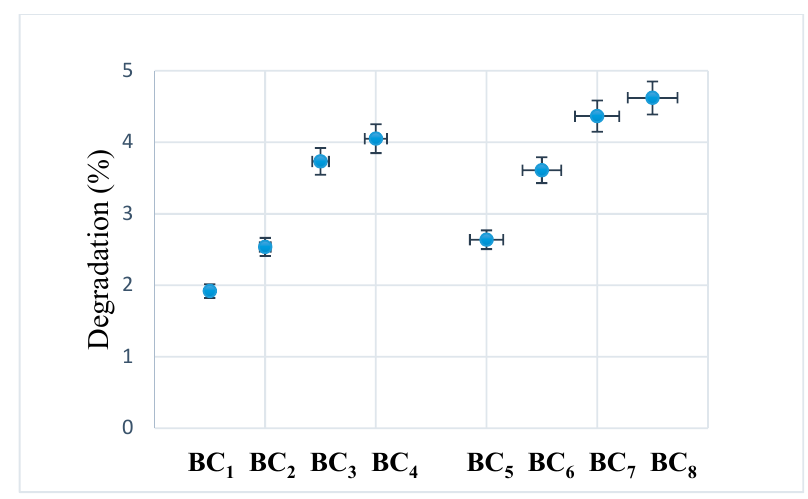
Figure 12. Degradability of composites after seven days of immersion in SBF at room temperature.